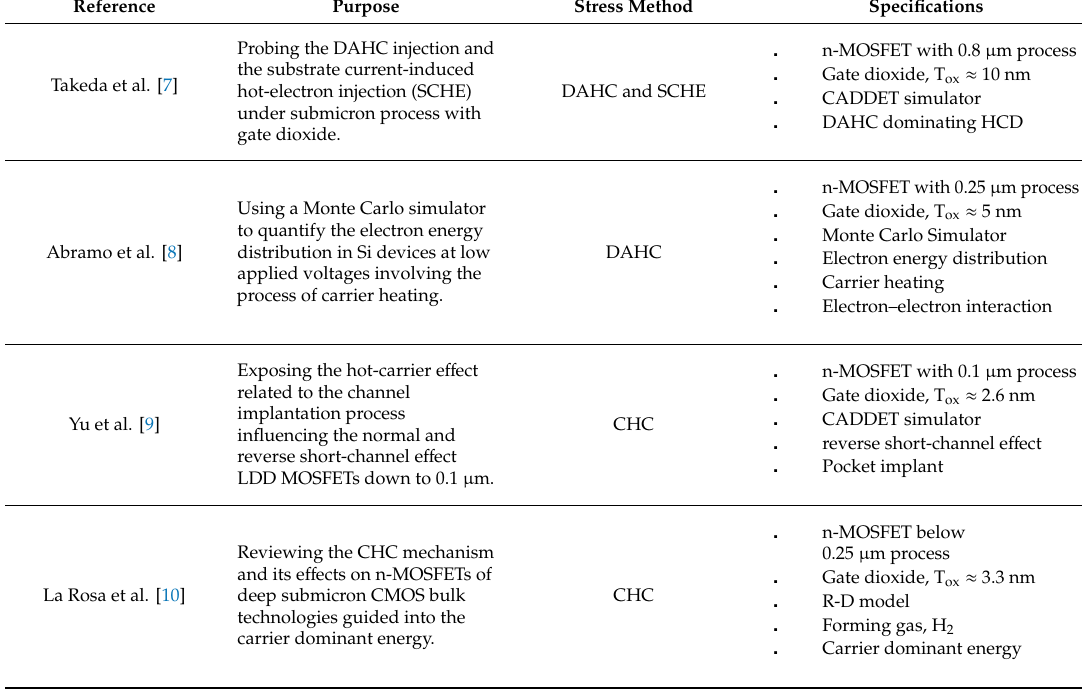
Table 1. The comparison of quoted references [7–12,17,22] in the former and present process